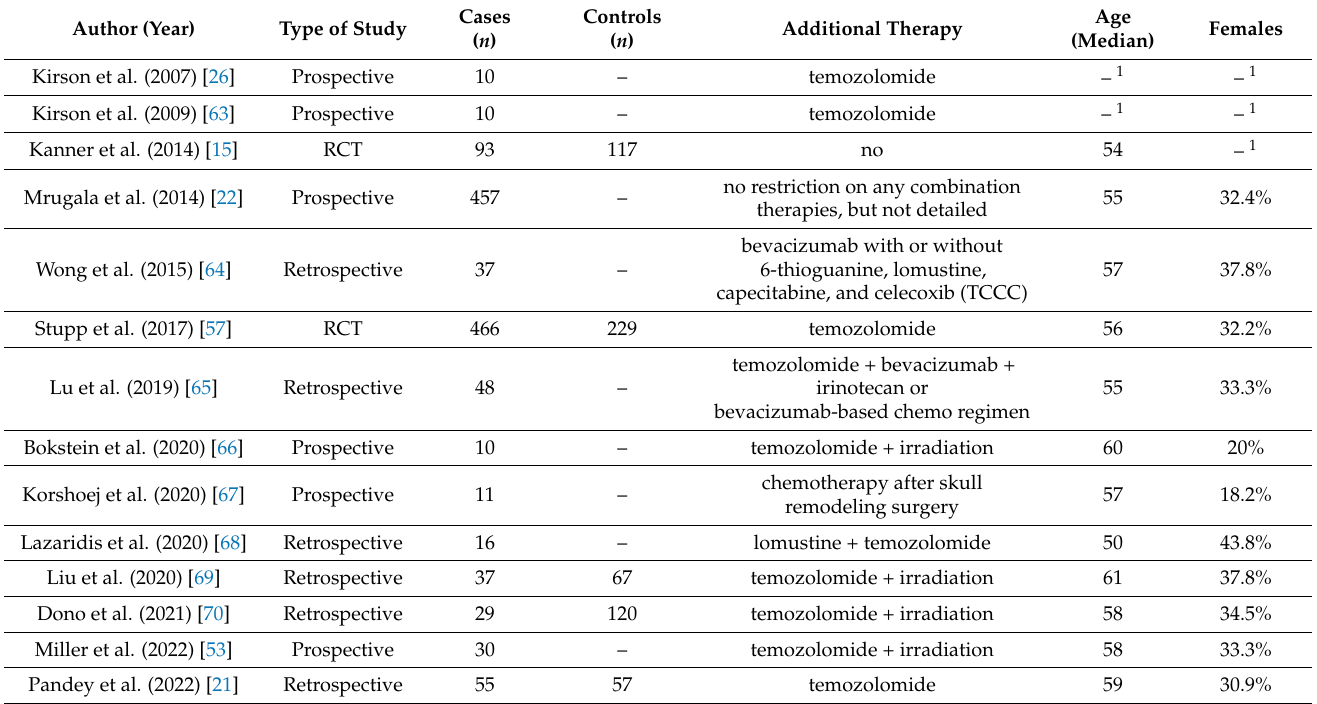
Table 2. Details of the selected studies investigating the effect of Tumor Treating Fields (TTF) in glioblastoma.